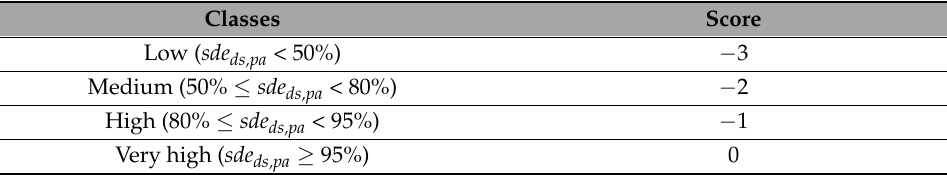
Table 8. SDe ds,pa —spatial